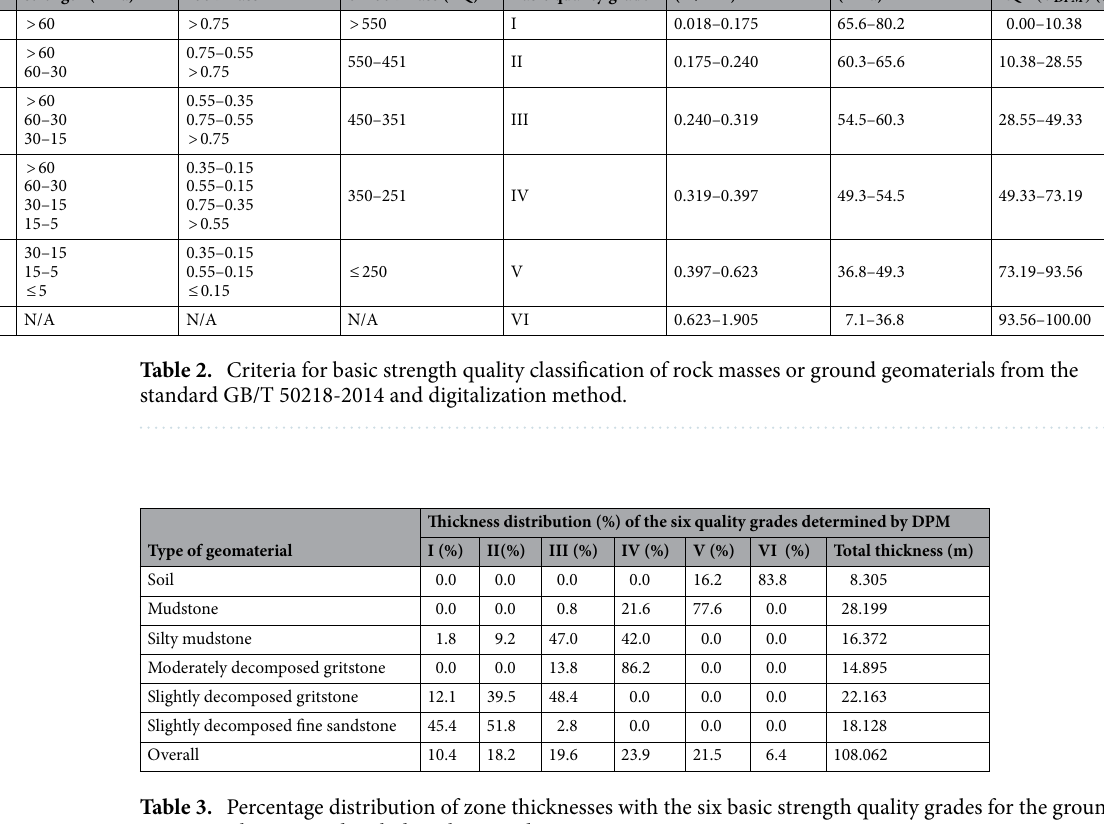
Criteria for basic quality classification of rock masses from GB/T 50218-2014